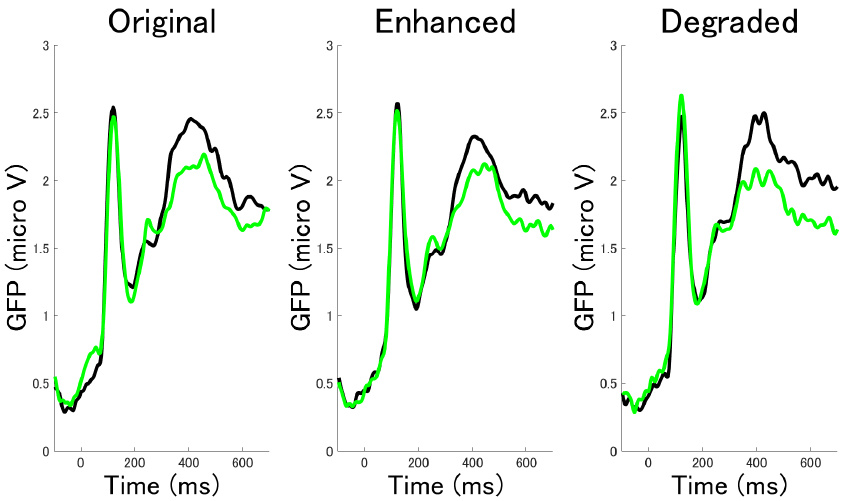
Figure 6. Temporal course of GFP in each condition. The black and green lines represent ERP waveforms for self and other familiar faces, respectively.